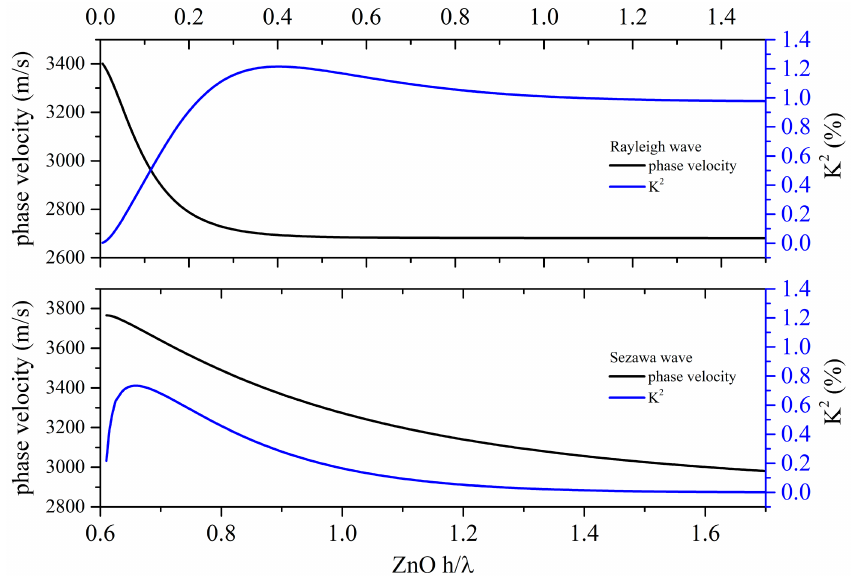
Figure 2. The phase velocity and K 2 dispersion curves of the Rayleigh and Sezawa waves in ZnO/fused silica.